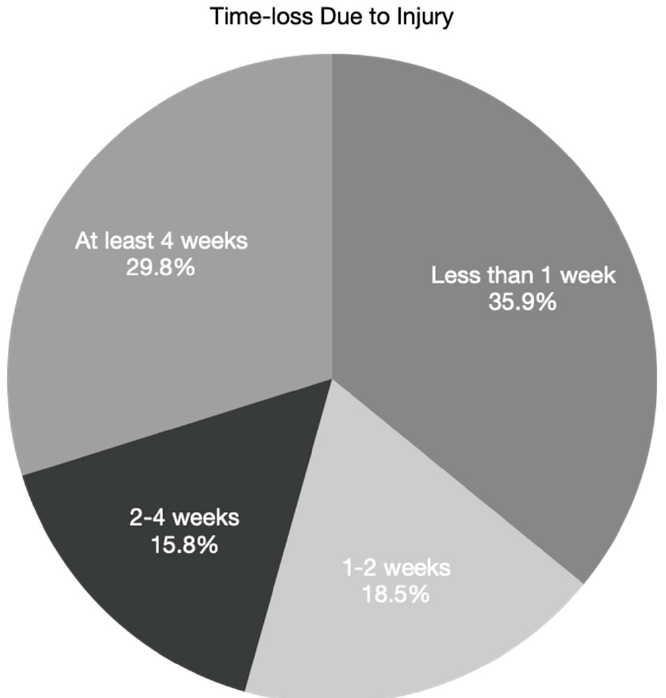
Figure 2. Time-loss due to injury. A total of 35.9% of injury events resulted in time-loss of less than 1 week, while 29.8% resulted in time-loss of at least 4 weeks from riding. For all years 2018–2020, injury events occurred during a team practice on mountain bike trails 60.2% (1009 events) of the time and during a race 25.0% (419 events) of the time. On the basis of incline, we found that 52.1% (873 cases) of injury events occurred while